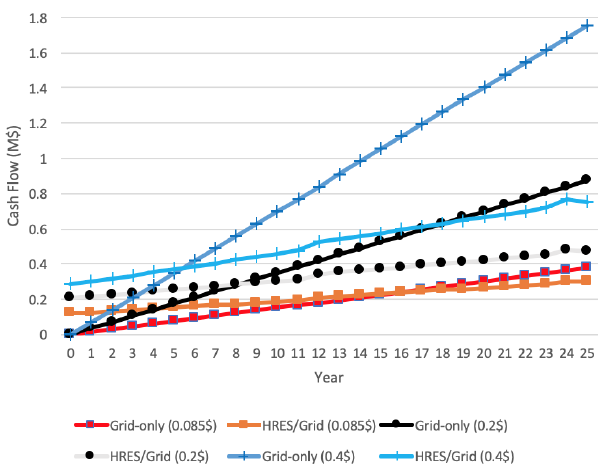
Figure 13: Payback period of grid’s tariff for Al Baha